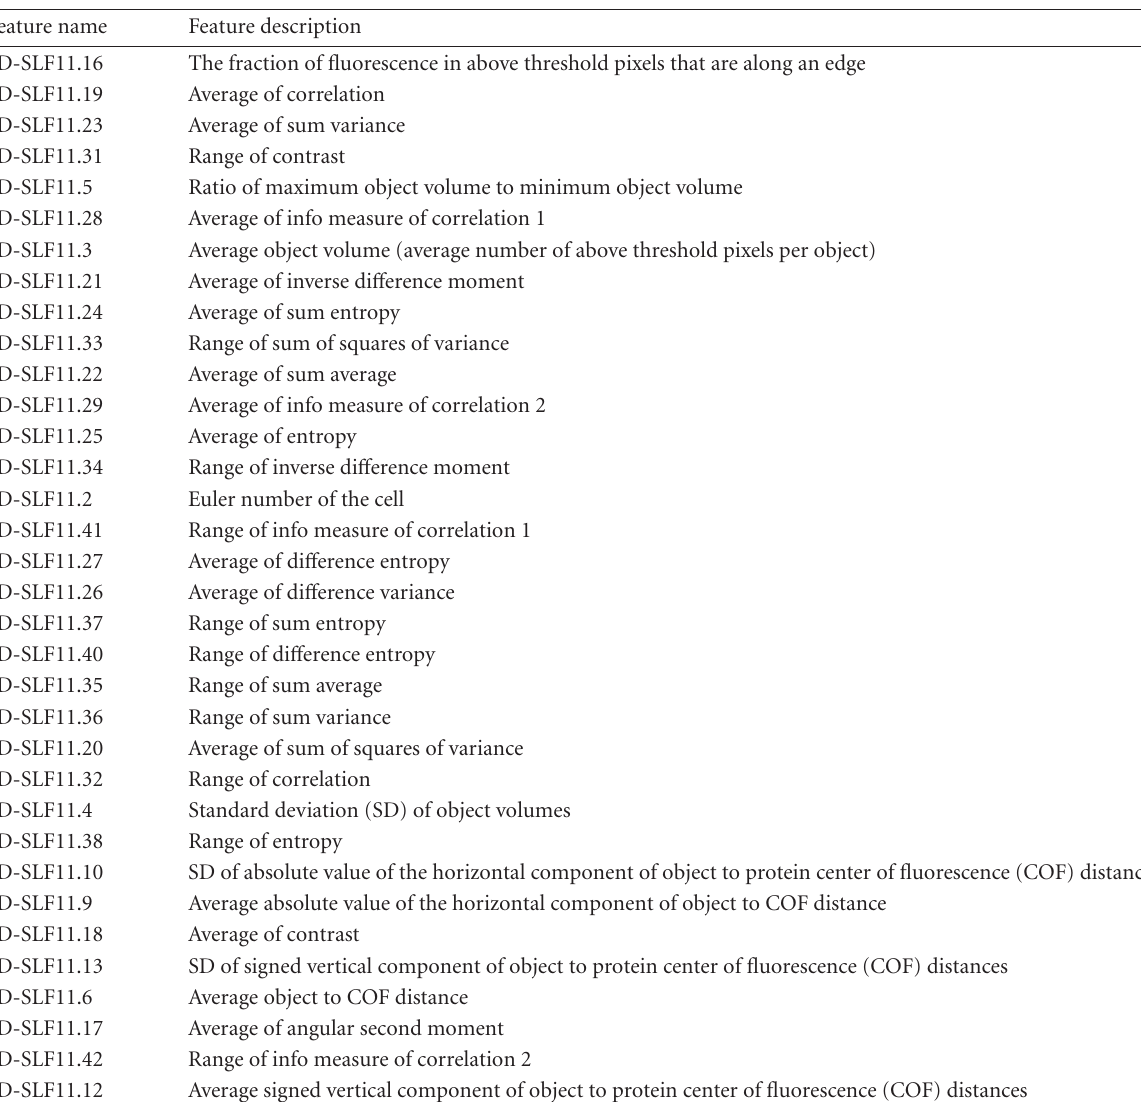
Table 1. Optimal feature set for distinguishing the 3D 3T3 images (3D-SLF18). The features are listed in decreasing order of discrim- inating power as evaluated by